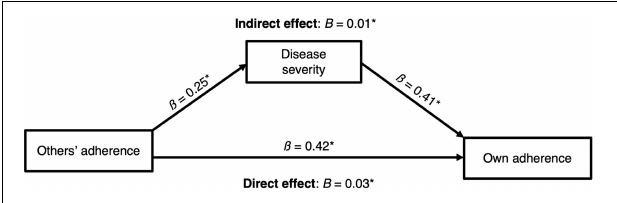
FIGURE 3 | Final mediation model with direct and indirect effects of perceived norms on adherence. * p < 0.05.